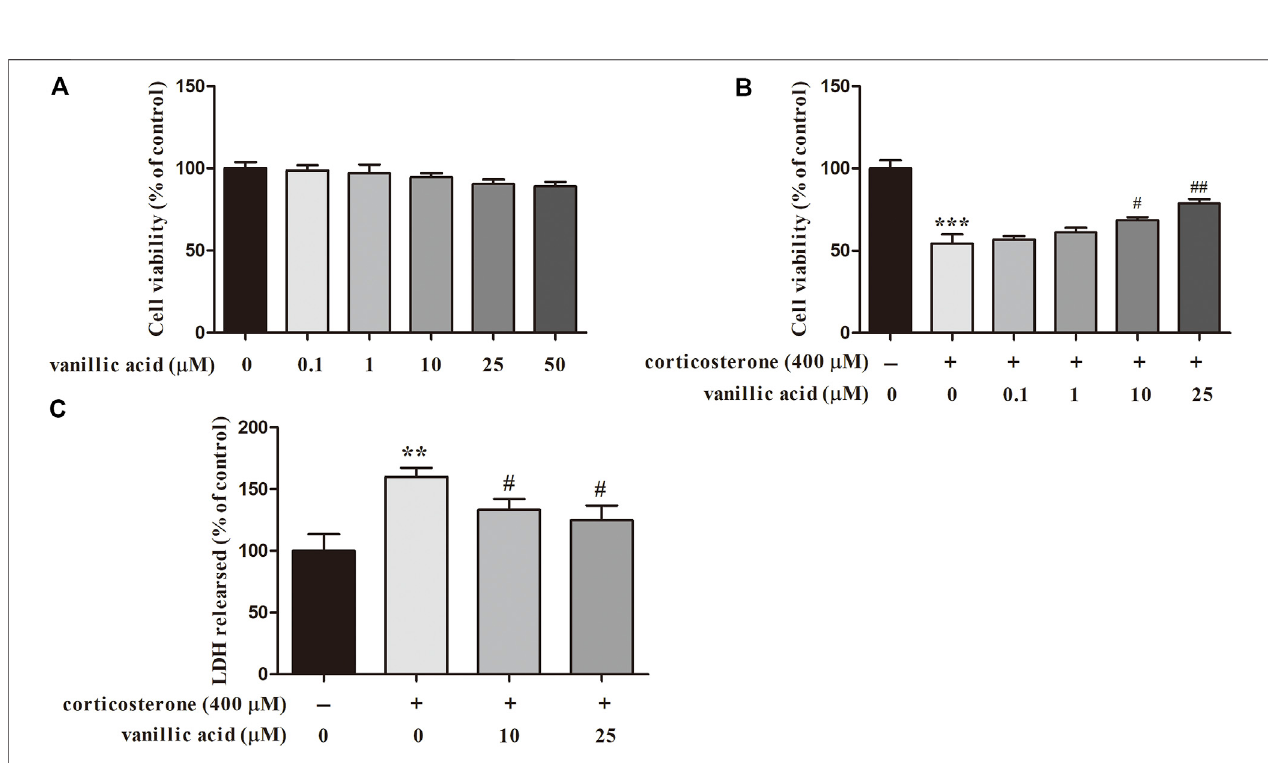
FIGURE9| EffectofvanillicacidaloneonPC12cells (A) andeffectofvanillicacidoncorticosterone-inducedapoptosisinPC12cells (B) ,effectofvanillicacidonLDHleakage on corticosterone-treated PC12 cells (C) . ** p < 0.01, *** p < 0.001 compared with that of the control group. # p < 0.05, ## p < 0.01 compared with the corticosterone group.